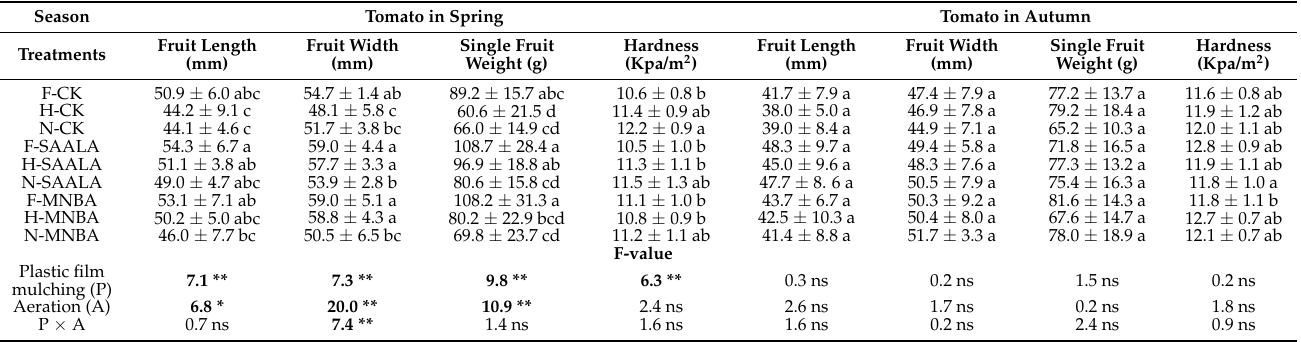
Table 6. Effects of different aeration treatments on shape indices of tomato.